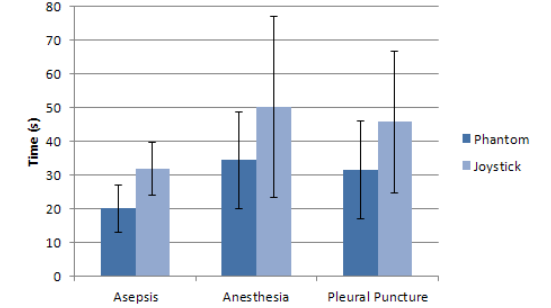
Fig. 22. Averages and standard deviation for the pleural tap procedure for Phantom Omni and Joystick input devices.